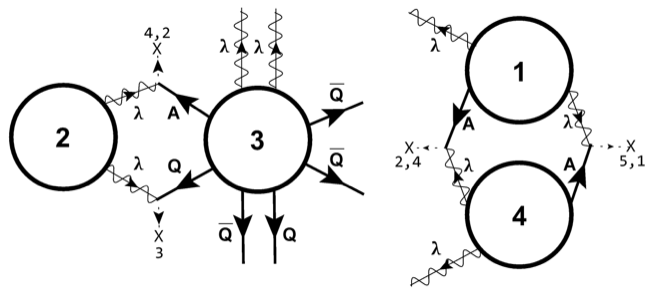
Figure 4: A sketch of the multi-monopole composites formed for F = 2 when the gauge group breaks from SU ( 5 ) to Sp ( 4 ) . The antisymmetric and squark VEVs, (61) and (62), are represented as a cross with their color